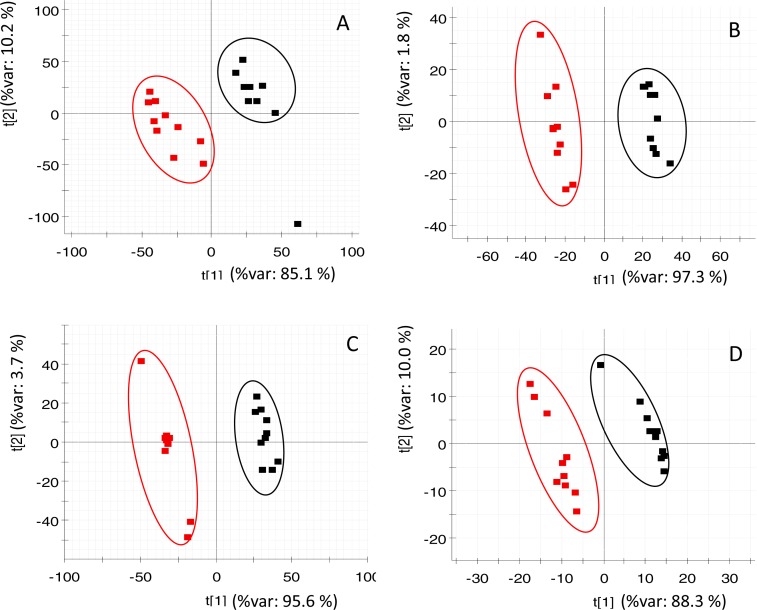
PLS-DA score plots of acquired data of fasted (red) and control (black) fish.X-axis corresponds to first component and Y-axis to second component (A) RP at positive ionization mode (B) RP at negative ionization mode (C) HILIC at positive ionization mode (D) HILIC in negative ionization mode.